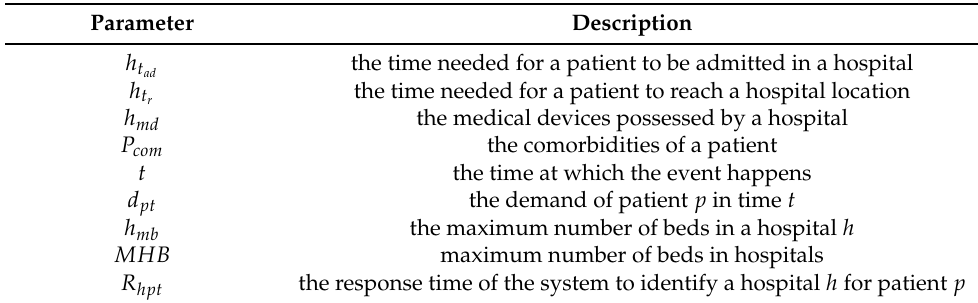
Table 1. A description of the main parameters of the problem